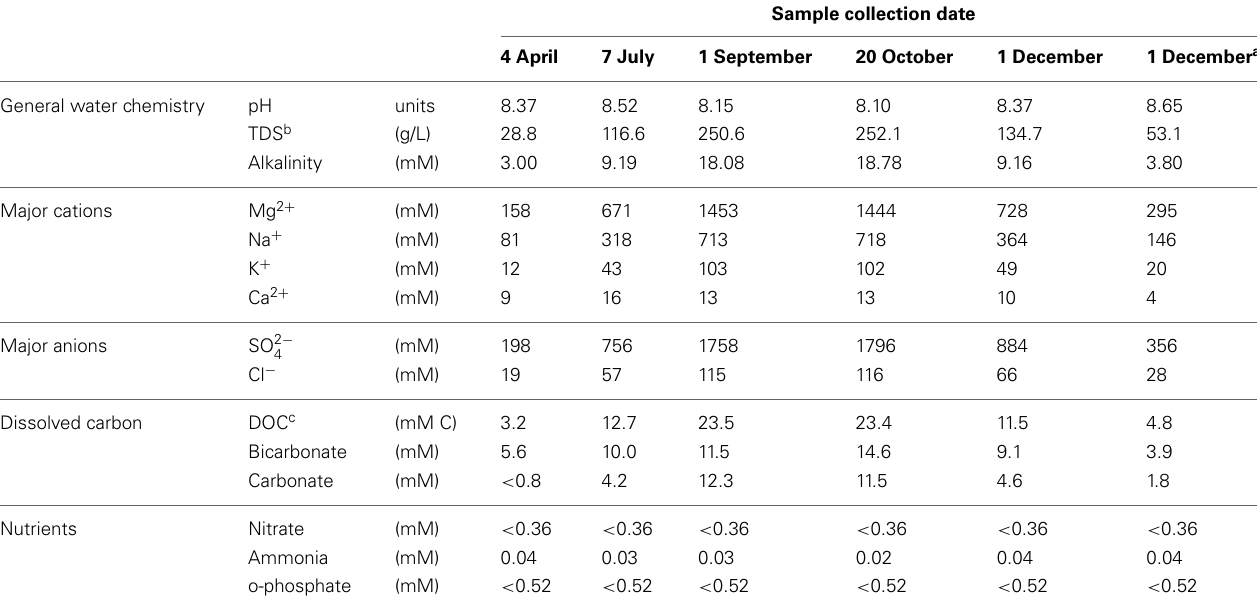
Table 1 | Aqueous geochemical analysis of mat-level